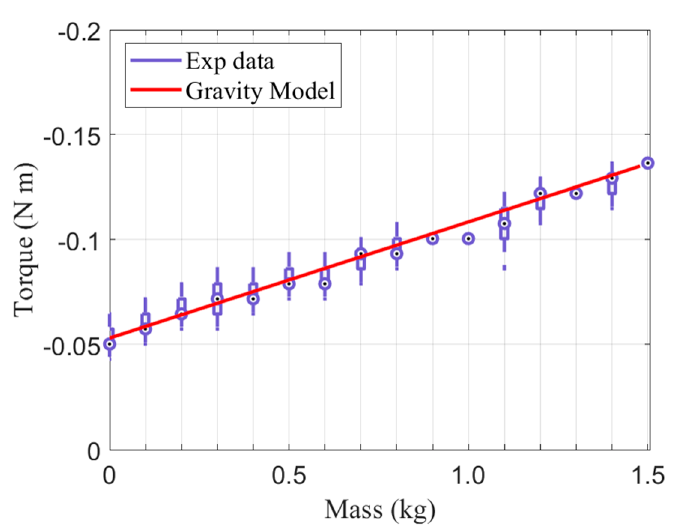
Figure 5. Torque due to the gravitational force of the additional mass. Table 2. Parameters for the gravity